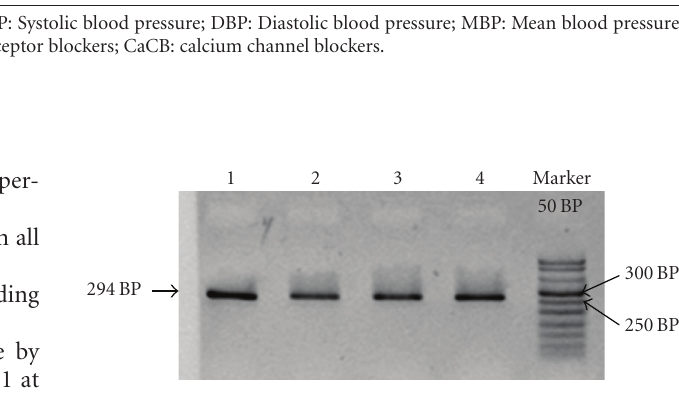
Figure 1: 2% agar gel for confirming the amplification fragment (294Bp). Subject 1–4, M marker 50Bp